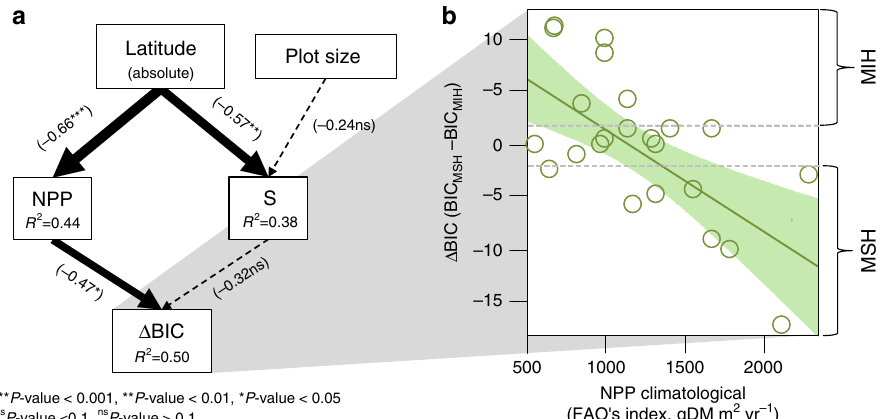
Fig. 4 Climate controls on causality of the richness-abundance relationship. The more species hypothesis is more likely in highly productive forest regions (climatologically speaking). a Graphical representation of the SEM outputs in which boxes represent the variables involved, arrows are illustrative of the causal paths, values in brackets denote the standardized coef fi cients (see legend of asterisks for P -value interpretation), and R 2 are the determination coef fi cients for the different regression models considered in the SEM. Solid arrows are indicative of signi fi cant pathways whereas dashed ones imply no signi fi cant relationships. b Δ BIC as linear function of NPP (FAO ’ s climatological index). The shaded area is illustrative of the 95% con fi dence interval around the marginal mean (solid line in green). Dashed lines represent 2 units of Δ BIC above ( + 2) and below ( − 2) 0, which is indicative of equivalent support for both hypotheses. According to the state of the art in model selection using information criteria, we established a band between + 2 and − 2 Δ BIC units in which supports for one or the other hypotheses are equivalent (more species (MSH) and more individuals (MIH)). NPP net primary productivity; S species richness, BIC Bayesian information